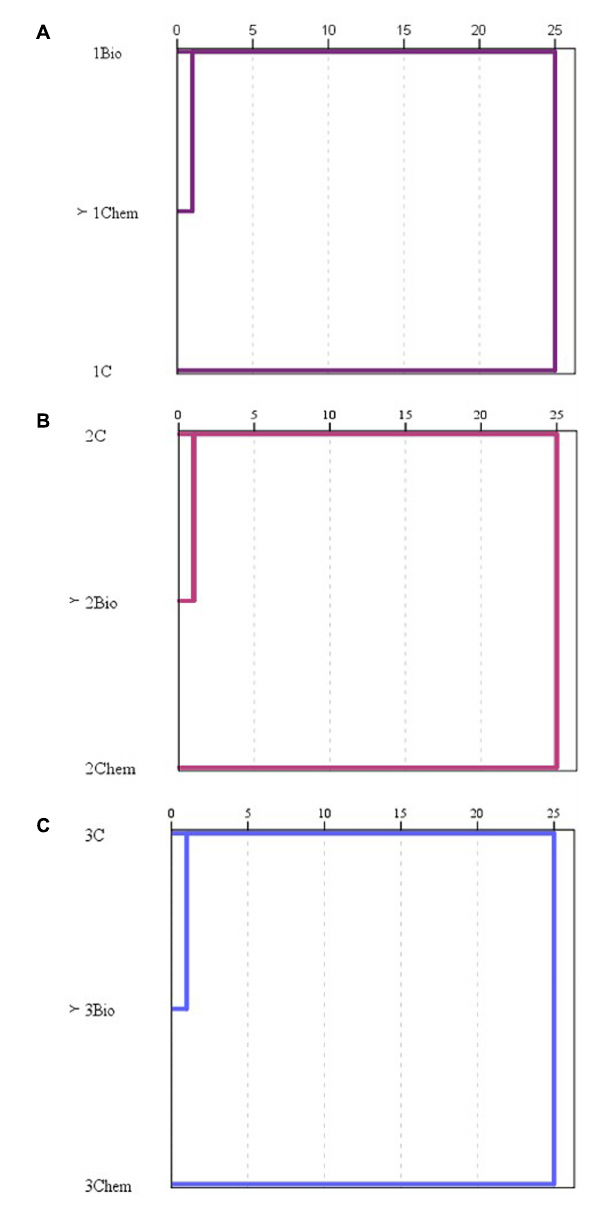
of species or in the structure of the microbial community of the three different samples were determined neither after the application of the bio-fungicide, nor after the application of the chemical fungicide. Only in the hierarchical cluster, both fungicide treatments were clustered in the same